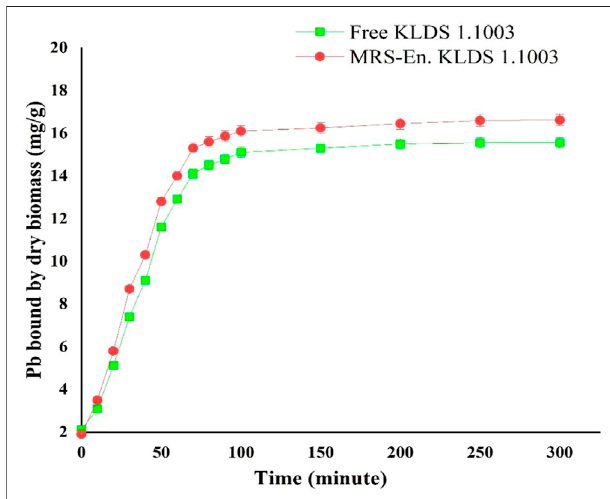
FIGURE 2 | Lead binding of free and MRS-based encapsulated L. acidophilus 1.1003 at different time points. Values are mean ± standard deviation (SD).